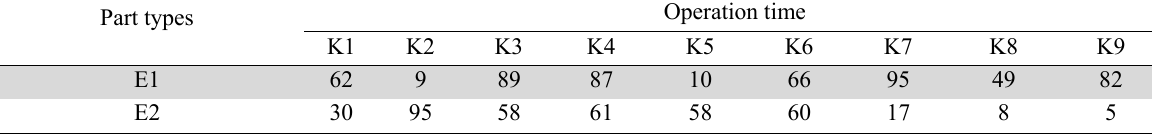
Operation time of parts at the production